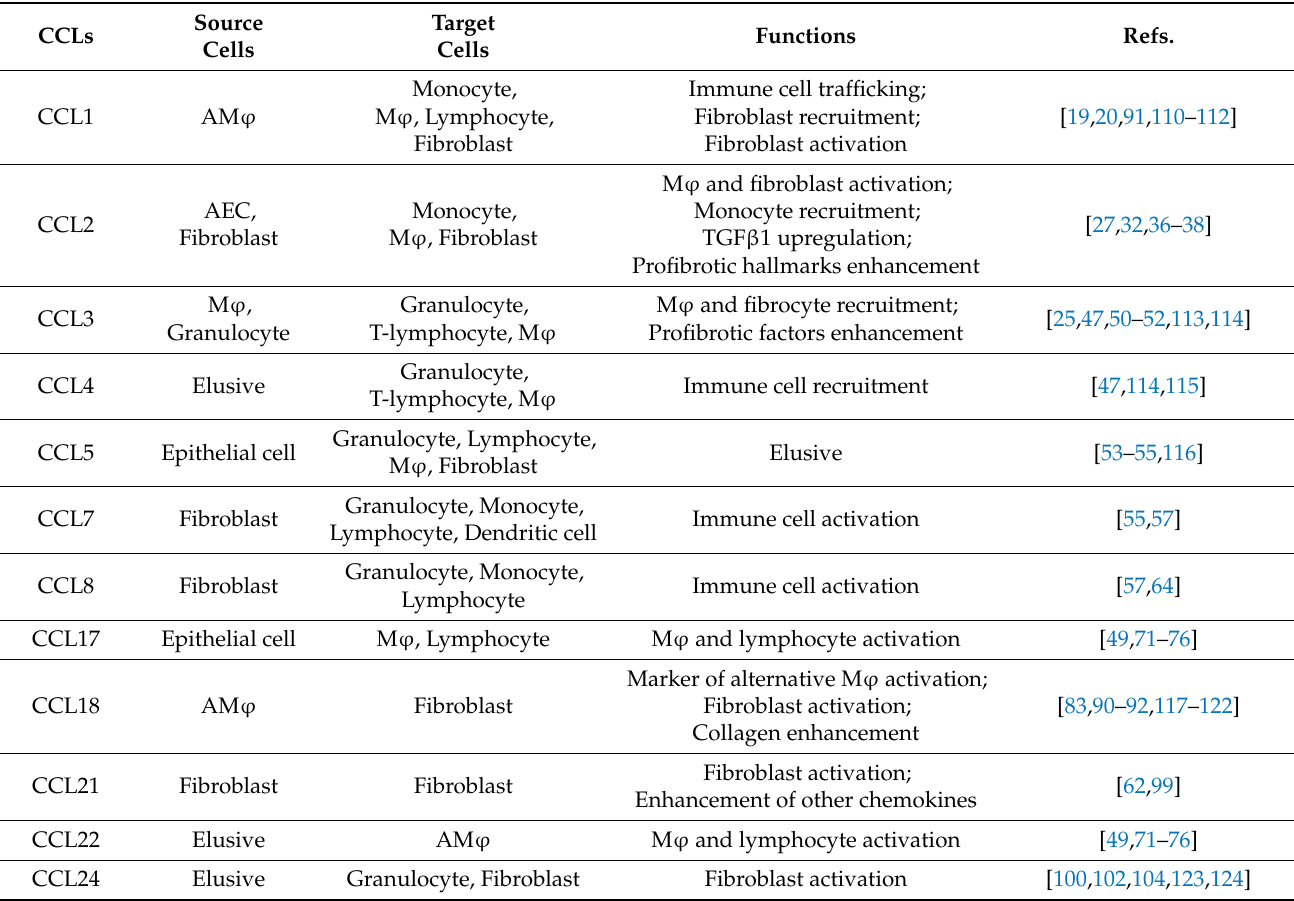
Table 2. Biological characteristics of CC chemokine functions in